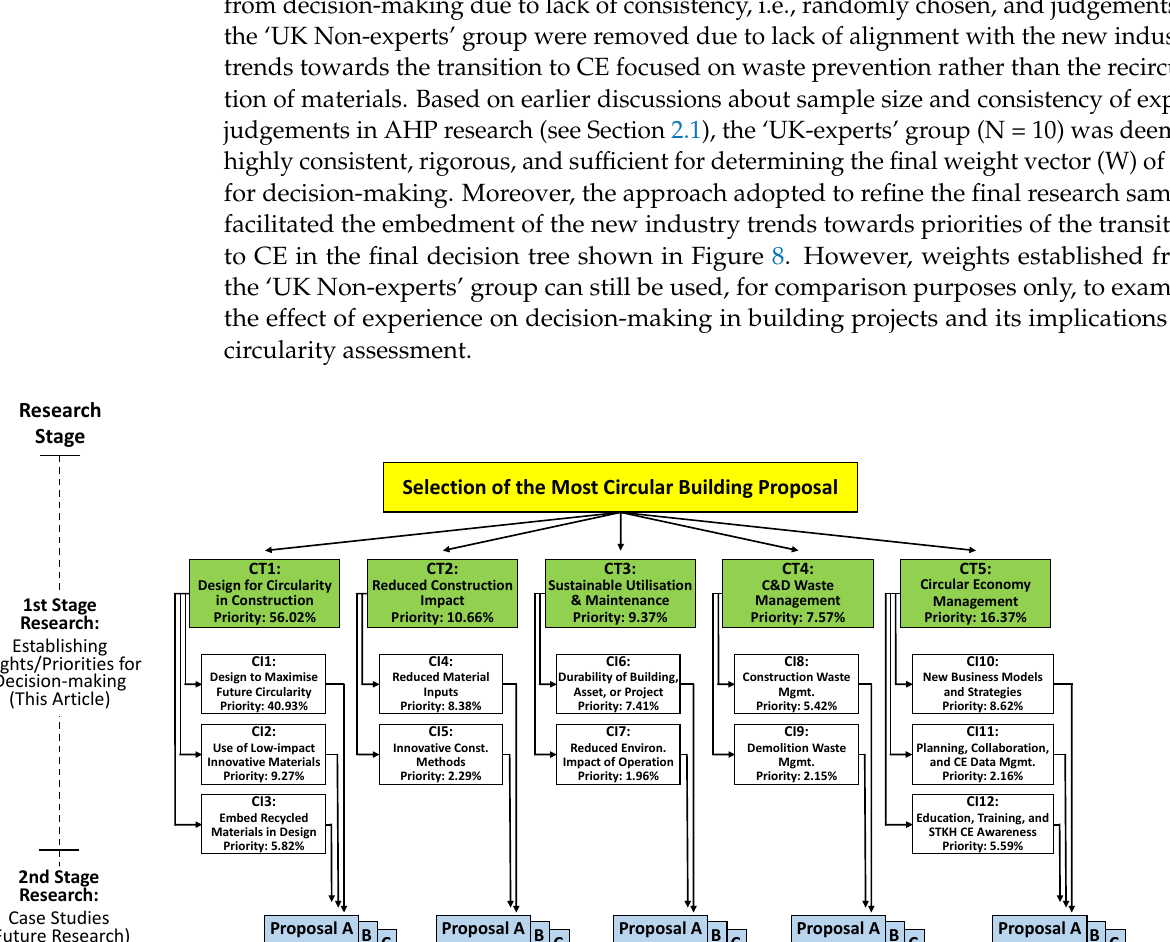
Figure 8. AHP MCDM model and final weights of CTs and CIs for use in circular proposal selection in building projects.